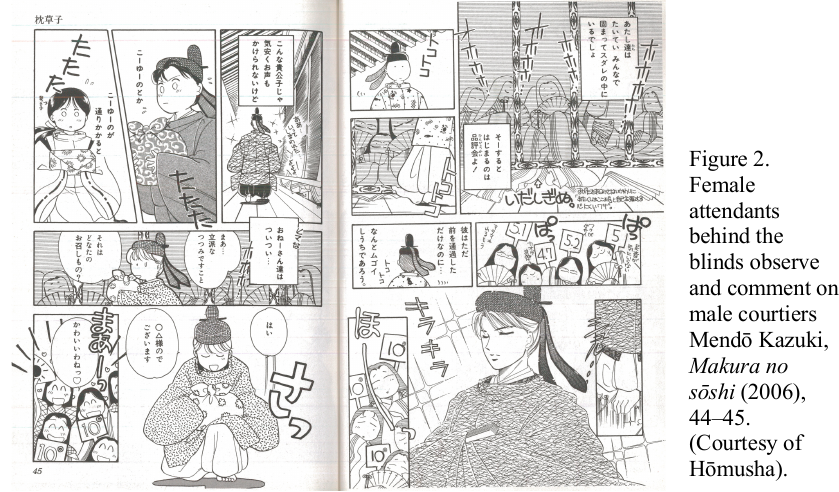
Figure 2. Female attendants behind the blinds observe and comment on male